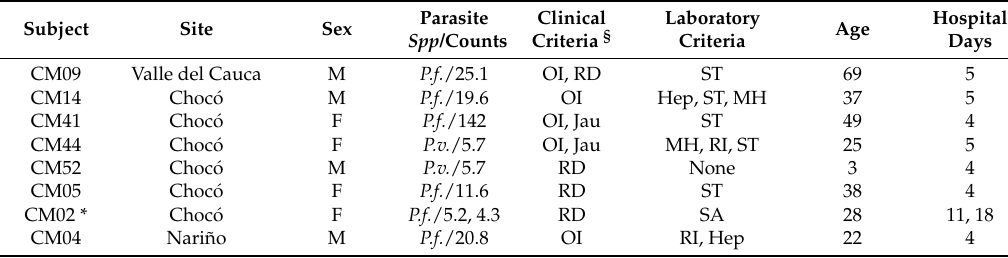
Table 1. Patient demographic, clinical, and laboratory